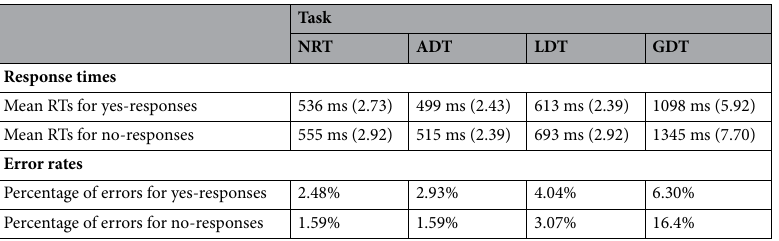
Table 1. Mean RTs (in milliseconds) for correct “yes” and “no” responses (standard errors in parentheses), and percentage of errors for yes and no-responses for each task. NRT non-reading task, ADT alphabetic decision task, LDT lexical decision task, GDT grammatical decision